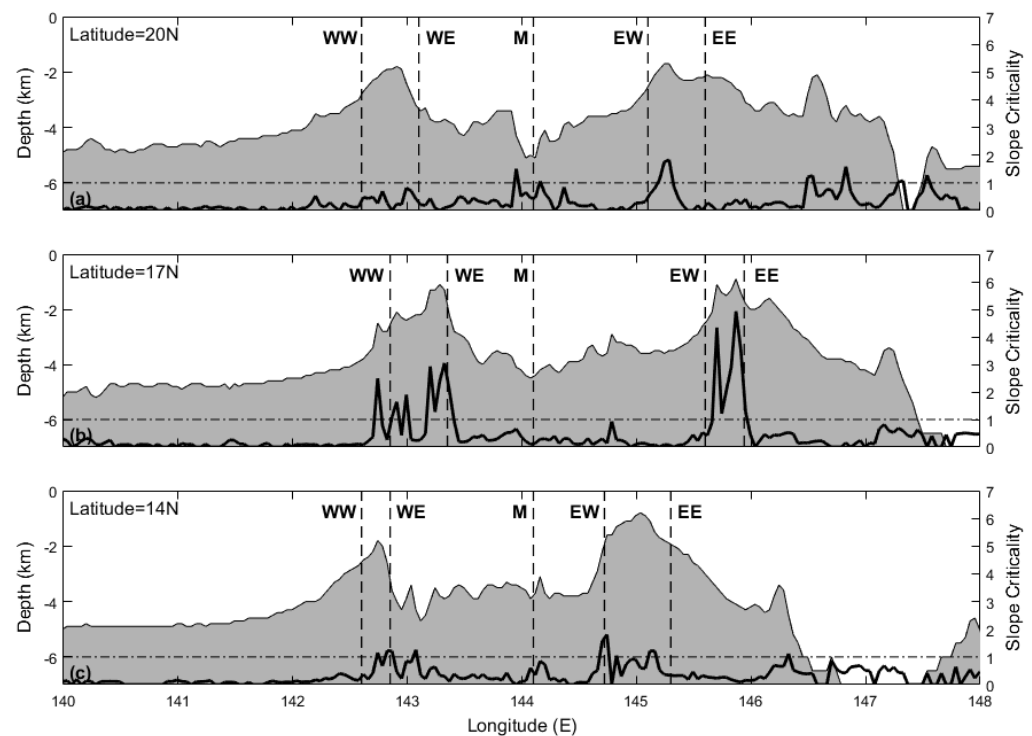
Figure 8. Sampled 5 stations (named WW, WE, M, EW, and EE) along 20 ◦ N ( a ), 17 ◦ N ( b ), and 14 ◦ N ( c ) sections (dashed vertical lines). The longitudes of the 15 stations are 142.6 ◦ E, 143.1 ◦ E, 144.1 ◦ E, 145.1 ◦ E, 145.6 ◦ E at 20 ◦ N; 142.8 ◦ E, 143.35 ◦ E, 144.1 ◦ E, 145.6 ◦ E, 145.94 ◦ E at 17 ◦ N; and 142.6 ◦ E, 142.85 ◦ E, 144.1 ◦ E, 144.72 ◦ E, 145.3 ◦ E at 14 ◦ N. The bold line represents the slope criticality. The horizontal dashed line represents the criticality index α = 1. Gray shaded areas represent topography along the sections.